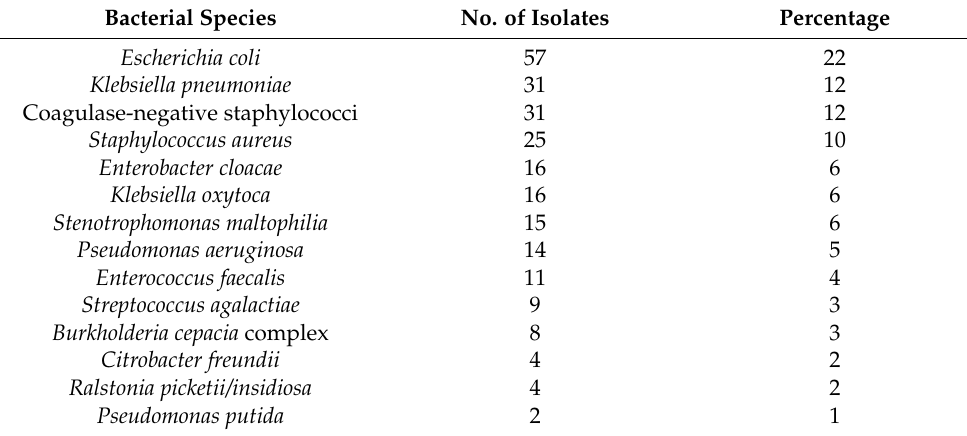
Table 1. Bacteria isolated from newborns prior to initiation of antibiotic therapy. Bacterial